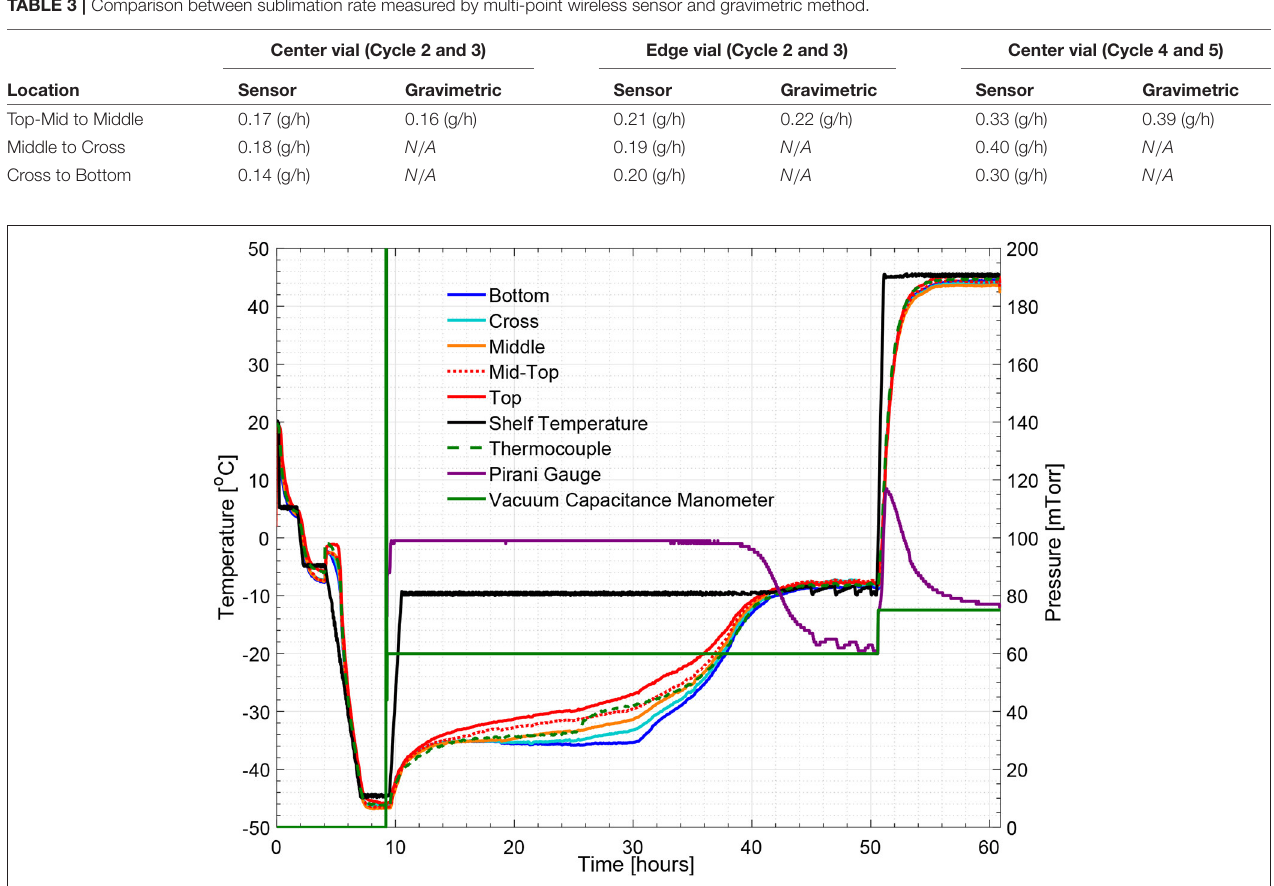
FIGURE 5 | Measured temperature and pressure over time profile of 5% w/v sucrose solution for a center vial (cycle